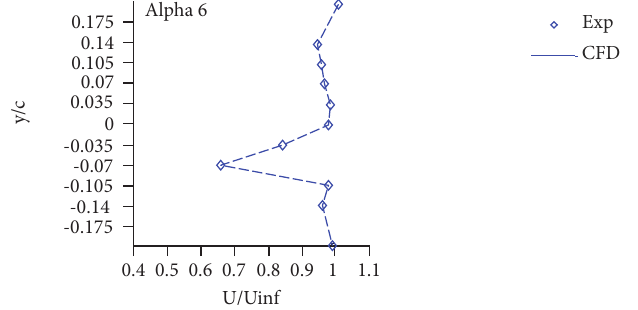
Figure 30. Streamwise velocity profile, pitch motion α (t) = 3 + 3 sin( w t), frequency = 3 Hz, Mach =